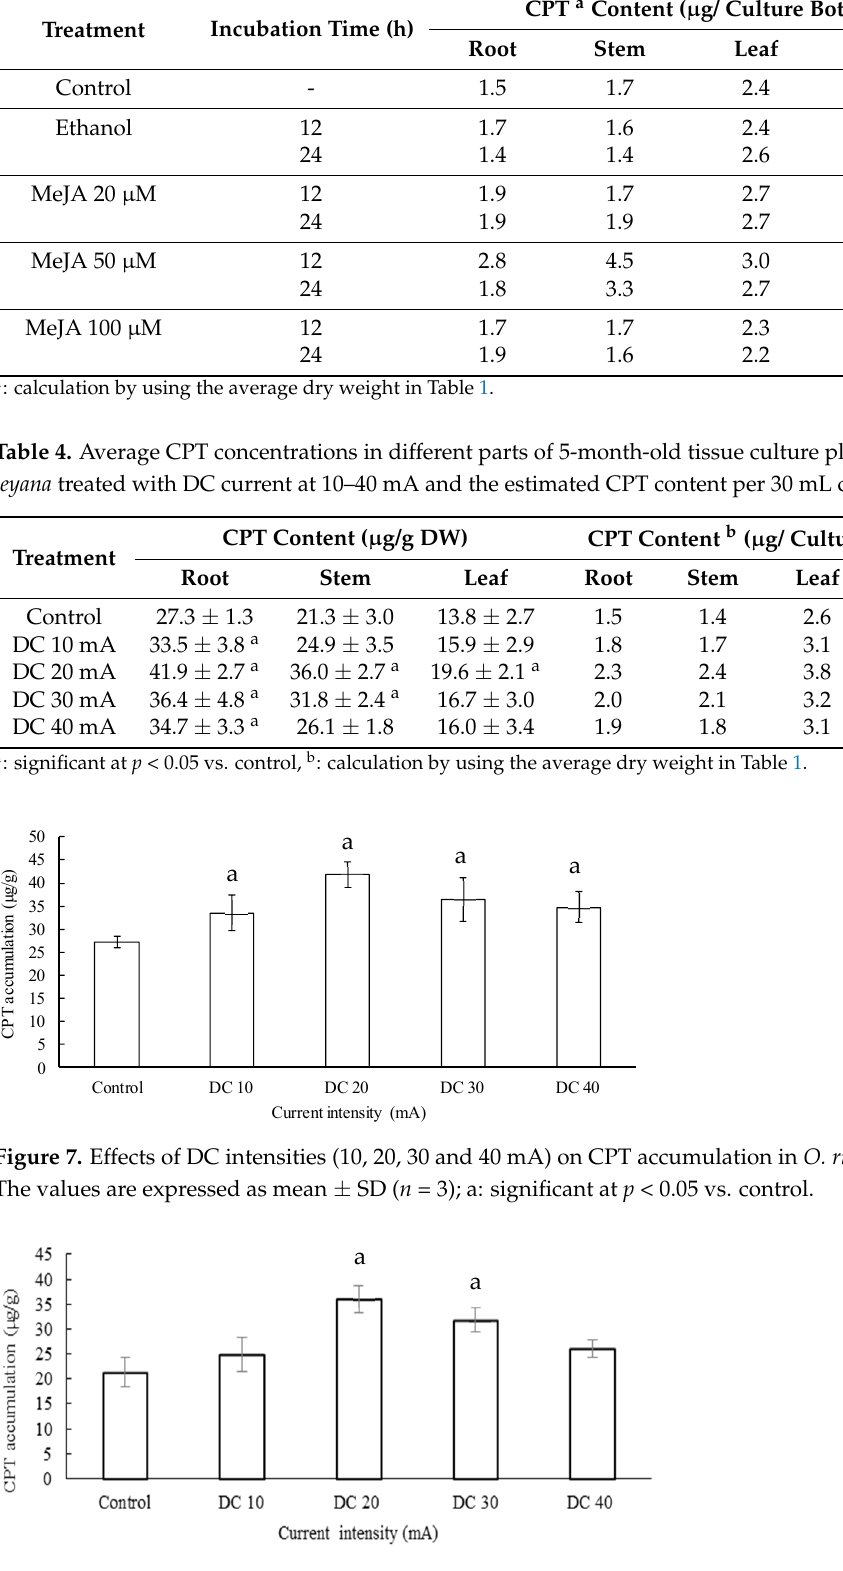
Figure 8. Effects of DC intensities (10, 20, 30 and 40 mA) on CPT accumulation in O. ridleyana stems. The values are expressed as mean ± SD ( n = 3); a: significant at p < 0.05 vs. control.